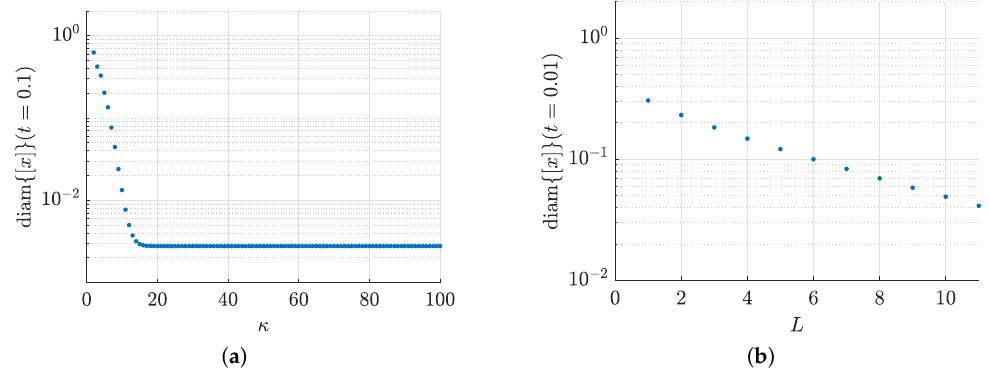
Figure 4. Dependence of the solutions according to Theorems 4 and 5 on the iteration numbers and series expansion orders in example (39): ( a ) Multi time step Picard iteration; ( b ) Temporal series